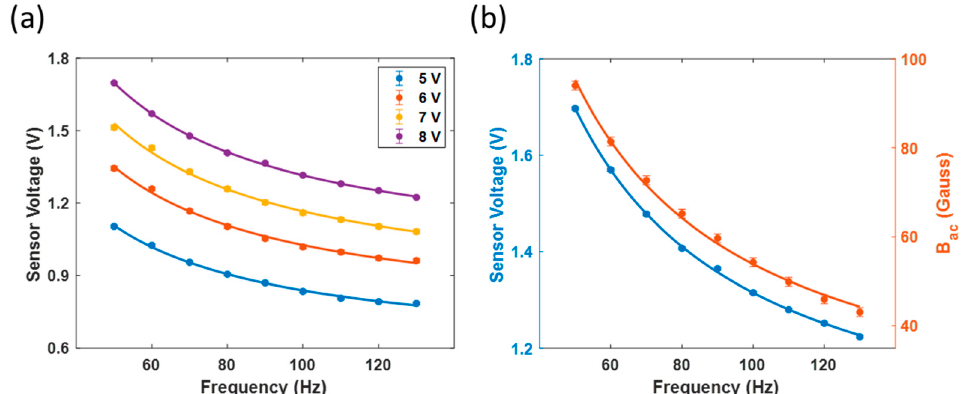
Figure 5. Measured RMS signal voltage versus AC magnetic field frequency. The solid dots are the measured data, whereas the solid lines are fitted curves to the inverse function. ( a ) The voltage signals are plotted with various function generator input voltage from 5 to 8 V. The data were fitted with Equation (6) with an error ~5 mV. ( b ) The sensor voltage signals (left axis) as well as the magnetic field measured with a Gauss meter (right axis) are plotted at 50 to 130 Hz. The magnetic field was fitted with an inverse function similar to the voltage function with an error of 1 gauss.